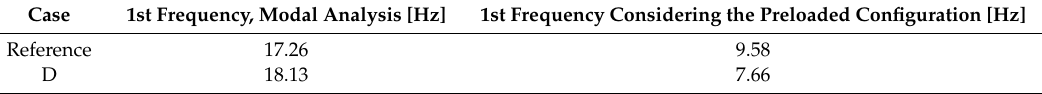
Table 10. The modal response of the actuator considering or neglecting the initial deformation due the pushing